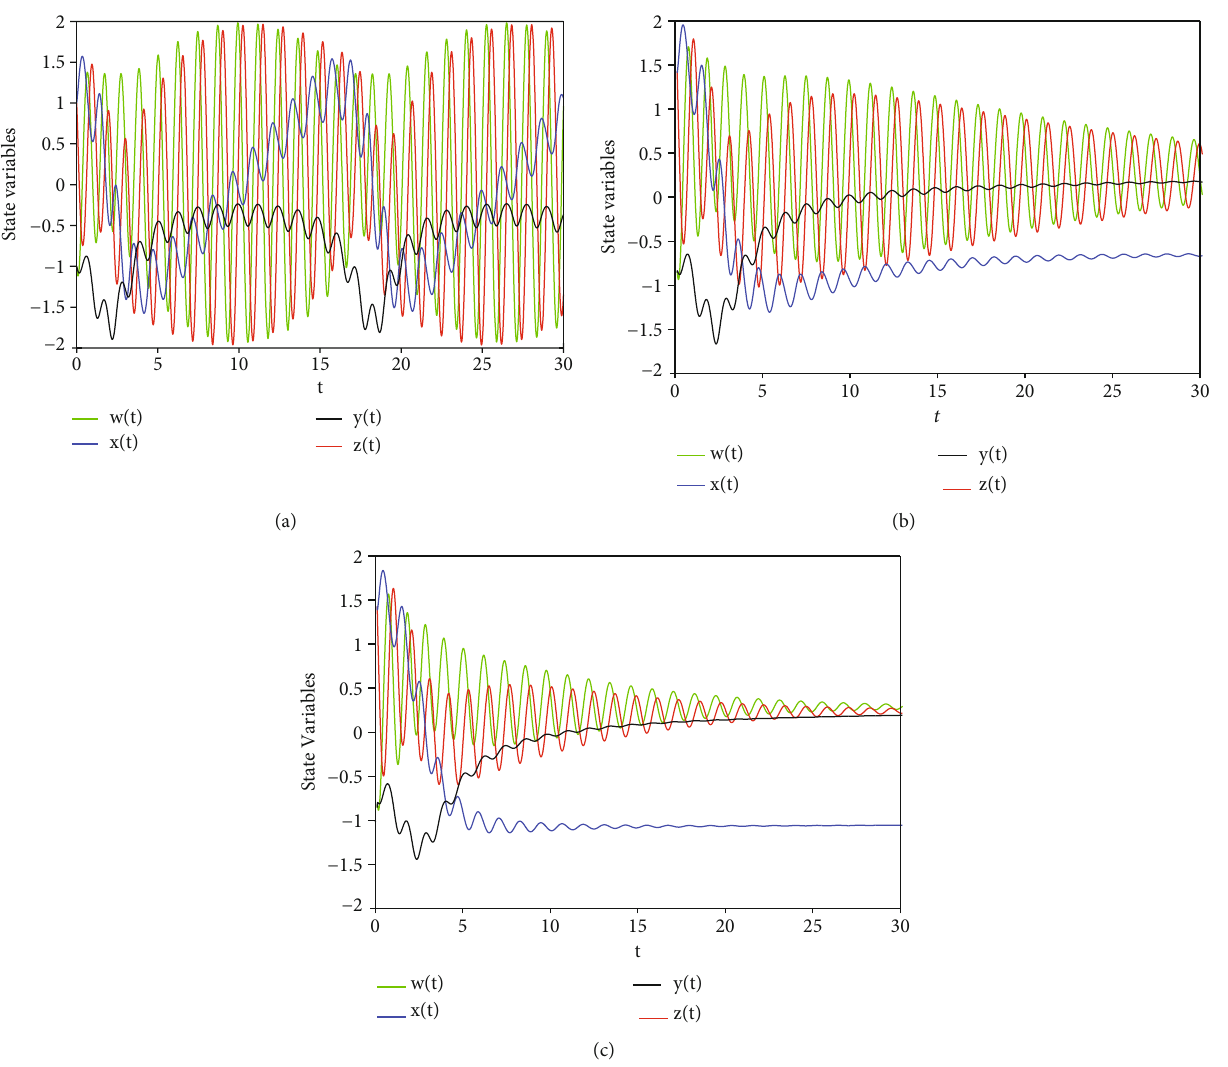
Figure 19: The behavior of di ff erent state variables of system 2 vs. time t with fractional order ϖ = 0 : 98 and the parameters n = 2, m = 2